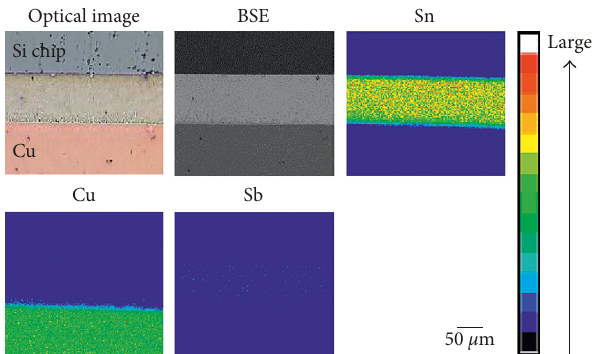
Figure 3: Optical image and back-scattered electron image of cross section of the solder joint with Sn-5Sb and its EPMA mapping analysis